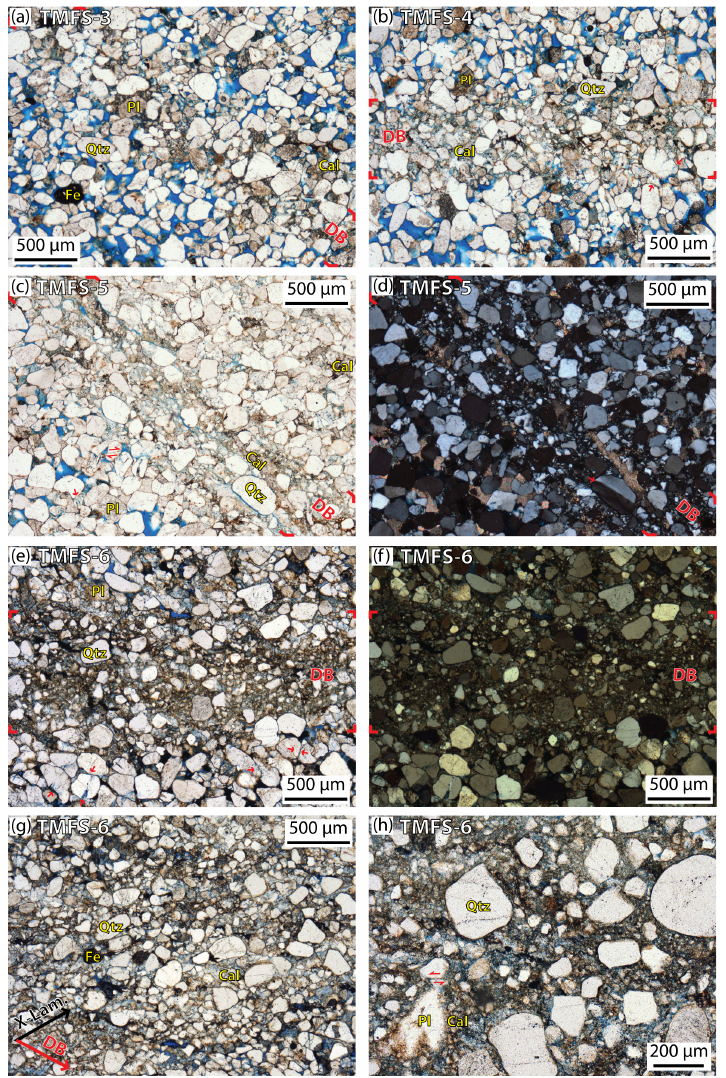
Figure 10. Thin section photomicrographs showing deformation band structure and porosity (edges of deformation bands highlighted in by red markers at edges of image). (a) Poorly developed deformation band in sample TMFS-3 (viewed in ppl) showing minor cataclasis (microcracks and fractures), embayed contacts and an increase in calcite cementation within the deformation band. Note the marked decrease in porosity within the host rock (13%–23%) and the deformation band (2.8%); (b) Deformation band in sample TMFS-4 (viewed in ppl) showing intragranular microcracks and transgranular fractures (red arrow), grain size reduction, and an increase in calcite cementation within the deformation band (host rock porosity 12.9%–14.9%, deformation band porosity 1.7%; Fig. 6); (c, d) Deformation band in sample TMFS- 5 viewed under ppl (c) and xpl (d) , (host rock porosity 7.4 %, def. band porosity ∼ 1 . 1%). Cataclastic fabrics within the deformation band includes angular smaller grains (grain size reduction), intragranular microcracks and microfractures, and increase in calcite cementation within the deformation band. Note, in xpl (d) the subgrain boundary within large quartz grain sub-parallel to band orientation, as well as microcracks, transgranular fractures and undulose extinction in some quartz grains outside the defined deformation band; (e, f) Deformation band in sample TMFS-6 viewed under ppl (c) and xpl (d) , (host rock porosity 3.2%–4.7%, deformation band porosity ∼ 1 . 6%). Deformation band shows well defined cataclastic fabrics (angular smaller grains, intragranular microcracks and microfractures, sheared and rotated grains) and an increase in calcite cementation. Note, the many strained grains (microcracks, transgranular fractures, undulose extinction, rotated grains and embayed contacts) outside the defined deformation band; (g) Sample TMFS-6 (viewed in ppl) showing deformation band cross- cutting a cross lamination within the sandstone (see annotation showing orientation of DB relative to laminae). Note the dominance of small angular grains in the section, reflecting grain fracturing within deformation band. (h) Sample TMFS-6 (viewed in ppl) showing microporosity with deformation band, note clean angular contacts to quartz grains and less distinct (“fuzzy”) grain boundaries to feldspar grains. Angular shear fracture in quartz grain highlighted with red arrows. Cal: Calcite spar; DB: Deformation Band; Fe: Iron staining; Pl: Plagioclase Feldspar; Qtz: Quartz; X-Lam: cross-lamination. Red arrows highlight zones of pressure solution, embayed contacts, and microfractures. Porosity values from ImageJ image